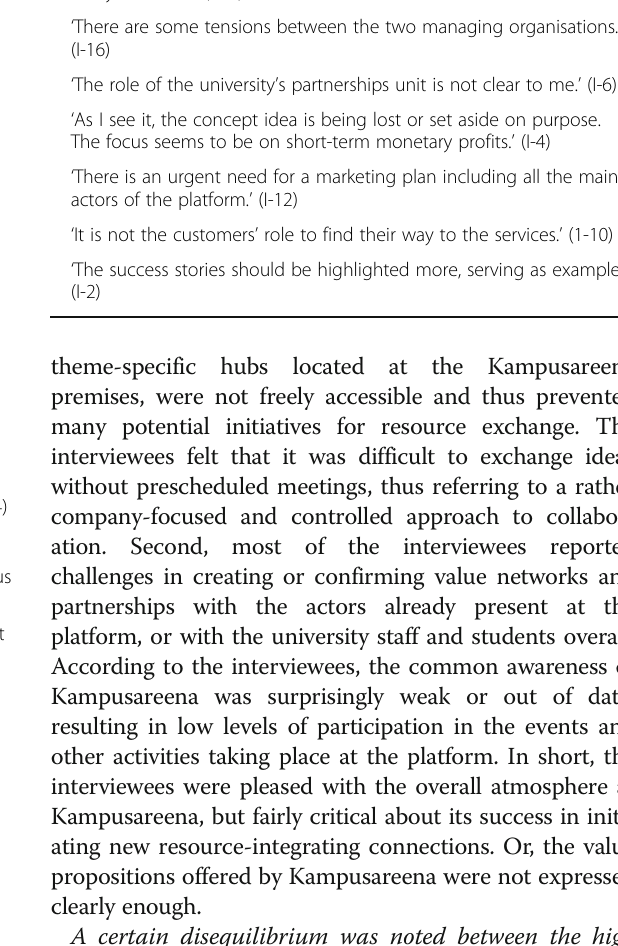
Co-elevation of the worldviews and values with (hidden) impacts on attitudes and behaviour Pioneers in university-industry